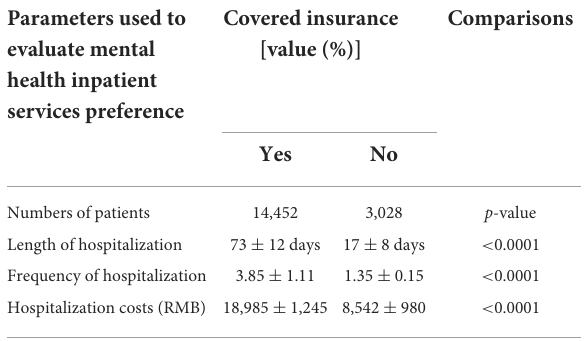
TABLE 6 Insurance information of the enrolled patients.